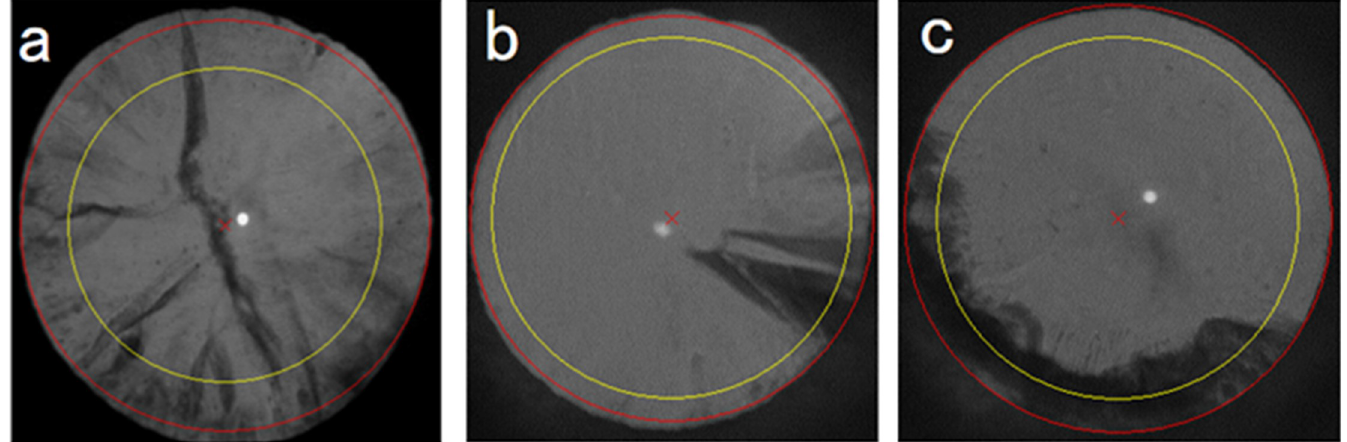
Fig 2. Cortical cataract opacity cases. a: axle-shaped opacity, b: wedge-shaped opacity, c: ring-shaped opacity. Inner circle (yellow) shows the central 6-mm diameter area of the pupil.